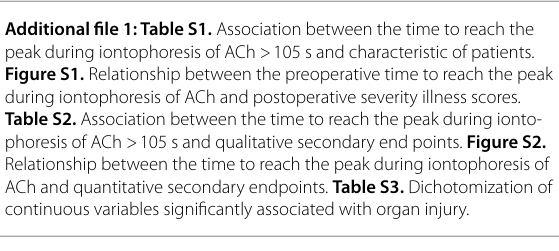
Figure S1. Relationship between the preoperative time to reach the peak during iontophoresis of ACh and postoperative severity illness scores. Table S2. Association between the time to reach the peak during ionto- phoresis of ACh > 105 s and qualitative secondary end points. Figure S2. Relationship between the time to reach the peak during iontophoresis of ACh and quantitative secondary endpoints. Table S3. Dichotomization of continuous variables significantly associated with organ